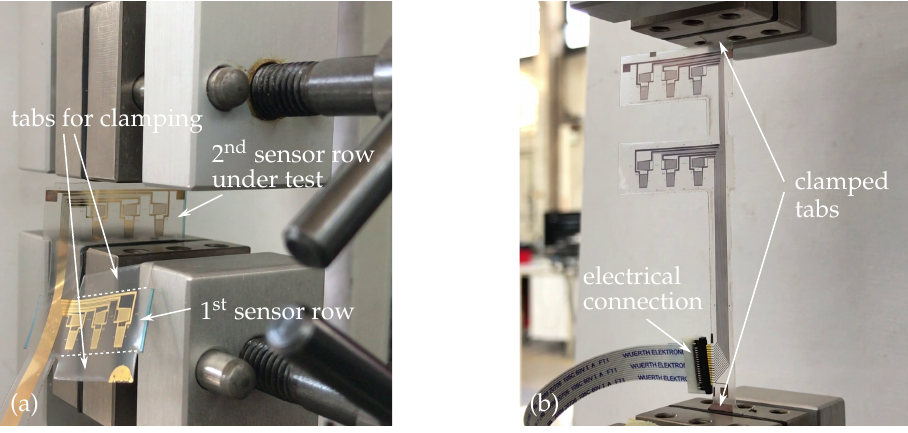
Figure 4. ( a ) Tensile testing of second sensor row. ( b ) Tensile testing of conductive